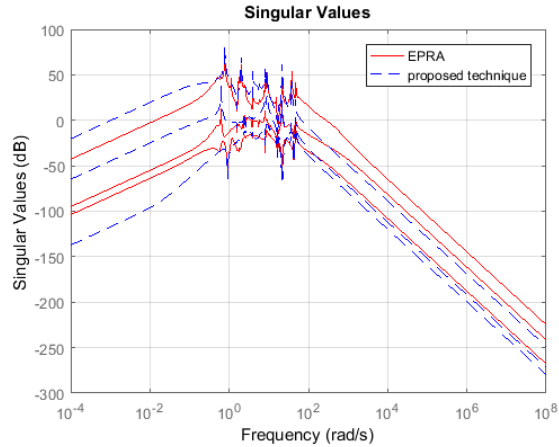
Figure 10. Sigma plot of 𝐾 𝑟 (𝑠)𝑃(𝑠) .